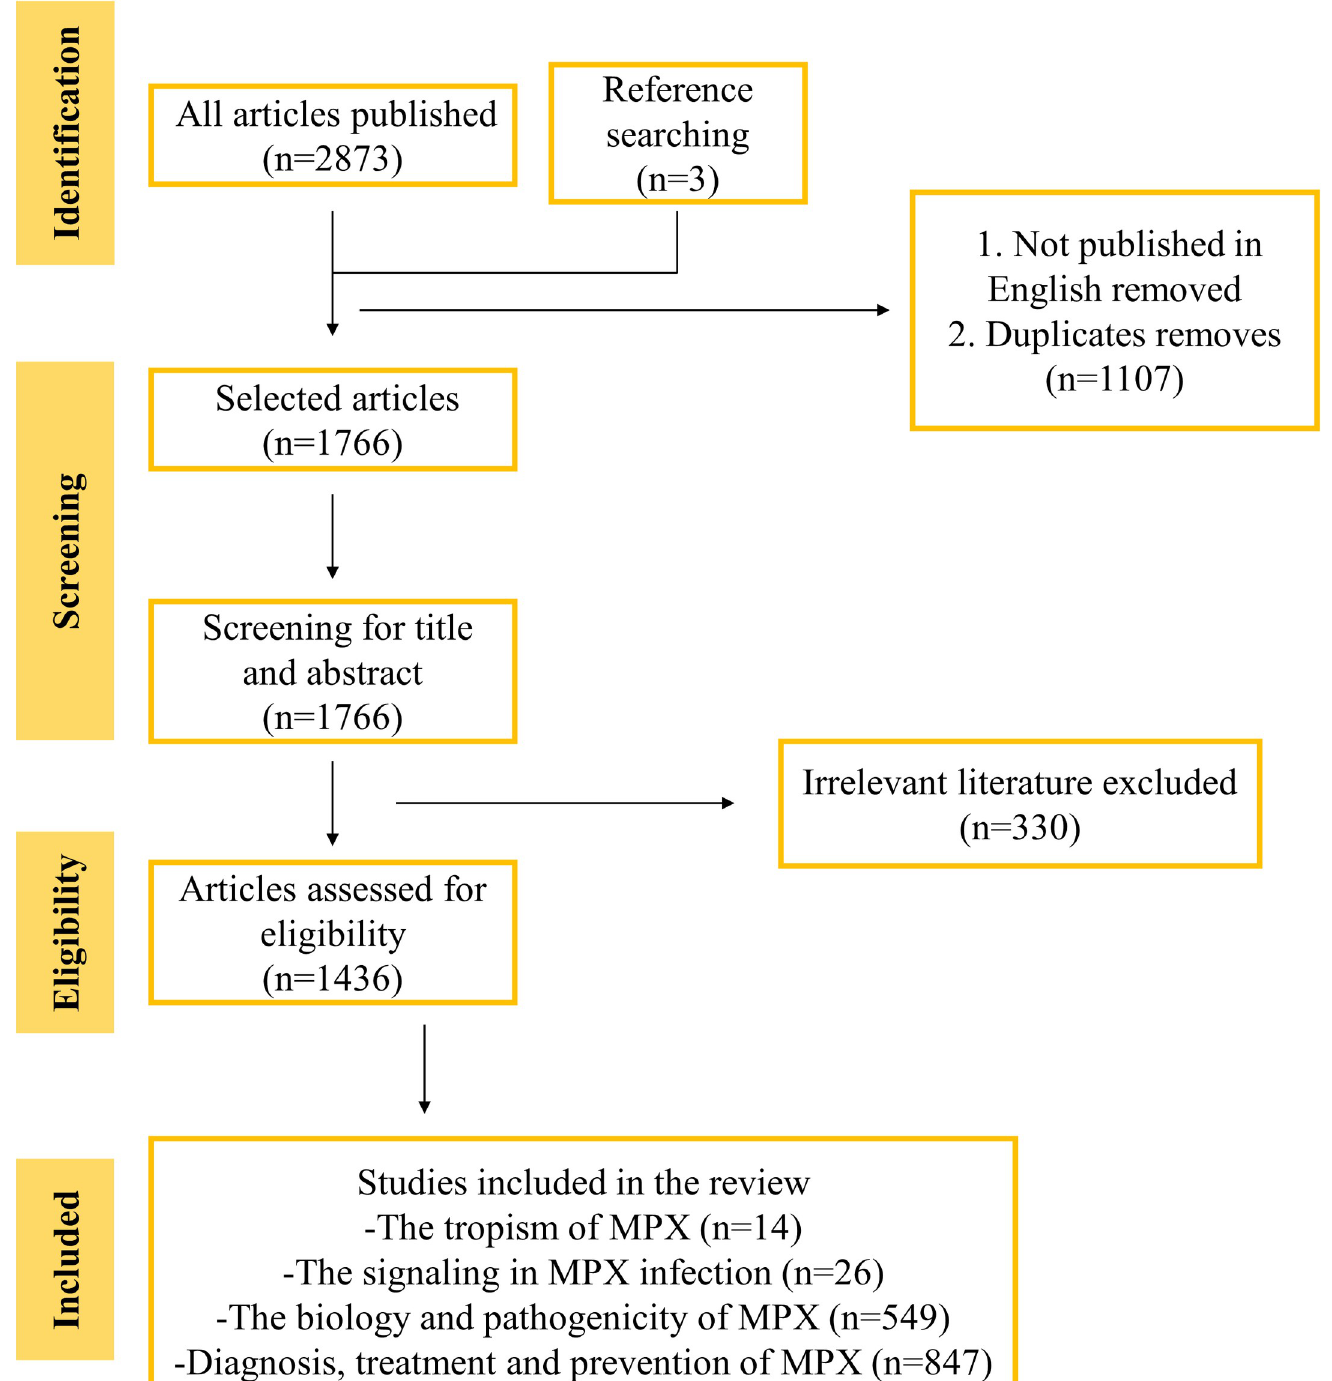
Fig 1. The study selection.